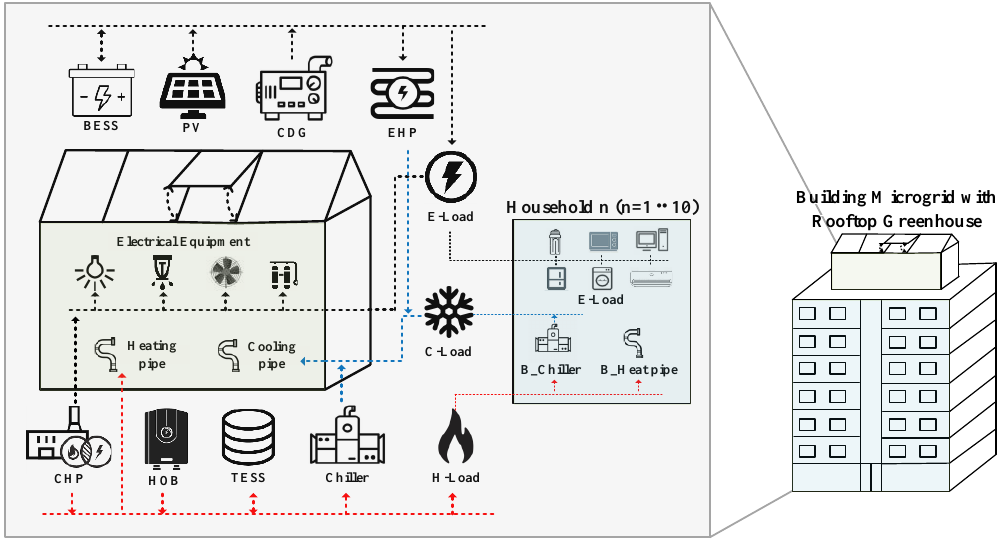
Figure 1. Configuration of the building microgrid with rooftop greenhouse considered in this study.